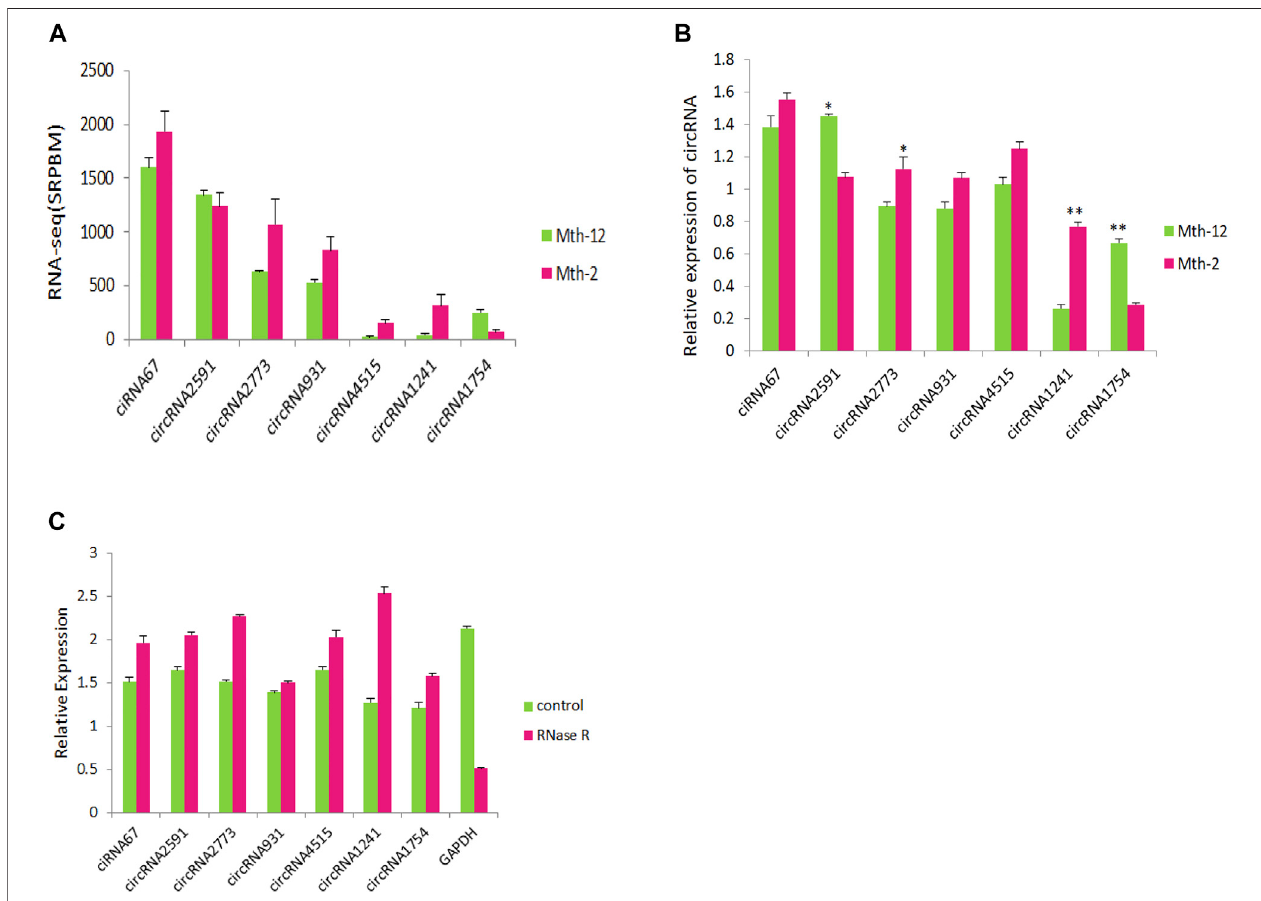
FIGURE 8 | Veri fi cation of circular RNAs (circRNAs) and resistance to RNase R. (A) Sequencing results of seven circRNAs; (B) Reverse transcriptase quantitative real-time PCR (RT-qPCR) veri fi cation results of seven circRNAs; (C) The expression levels of circRNAs, and GAPDH after RNase R treatment.